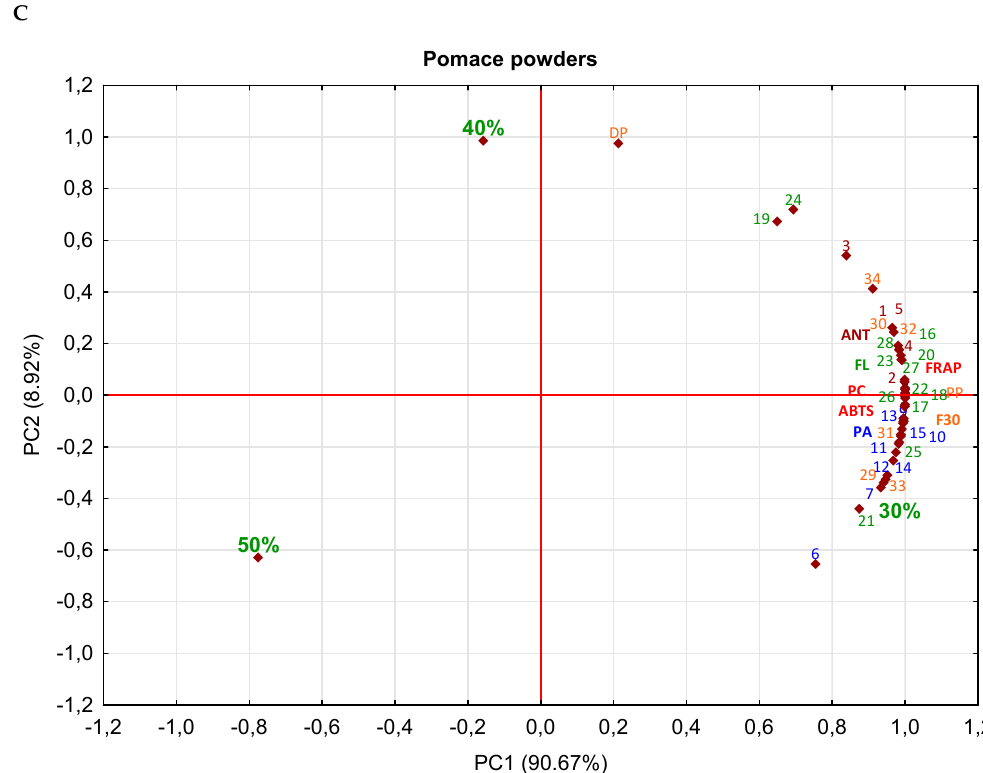
Figure 2. Principal component analysis (PCA) of the impact of carriers’ concentration on phytochemicals in fruit ( A ), juice ( B ), pomace ( C ) powders. Abbreviations: 30%, 40%, 50%,